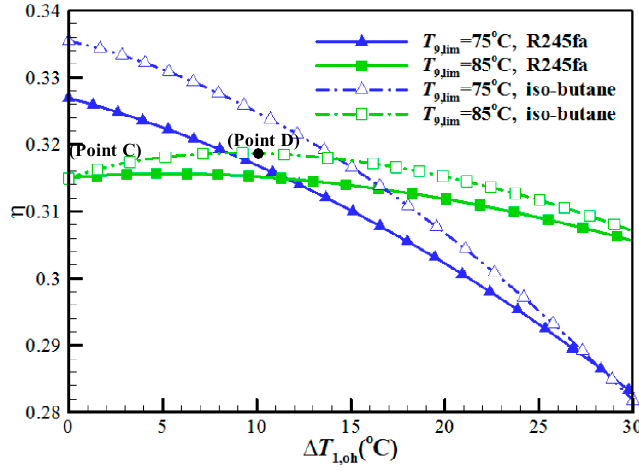
Figure 10. Plant exergy efficiency versus overheating degree with reinjection temperance limit.